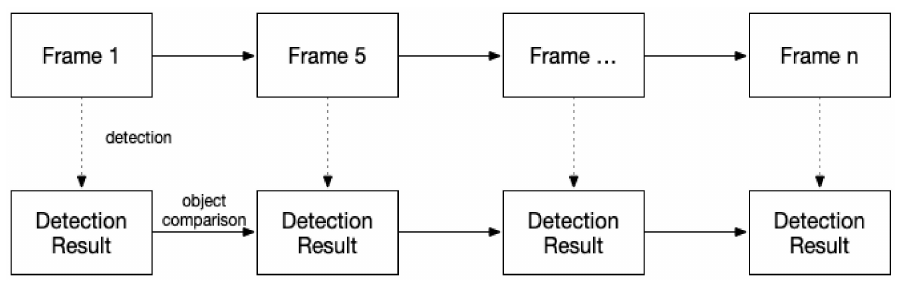
Figure 6. Object comparison between two adjacent